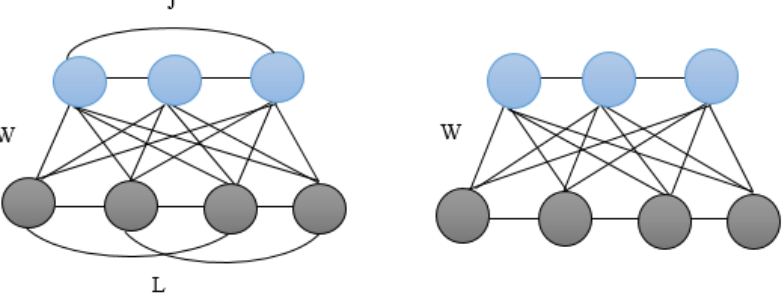
Figure 10. Left: A general Boltzmann machine. The top layer represents a vector of stochastic binary “hidden” features and the bottom layer represents a vector of stochastic binary “visible” variables. Right: A restricted Boltzmann machine with no hidden-to-hidden and no visible-to-visible connections. Where L, J, and W represent the visible layer, hidden layer, and connection weight between the layers respectively.